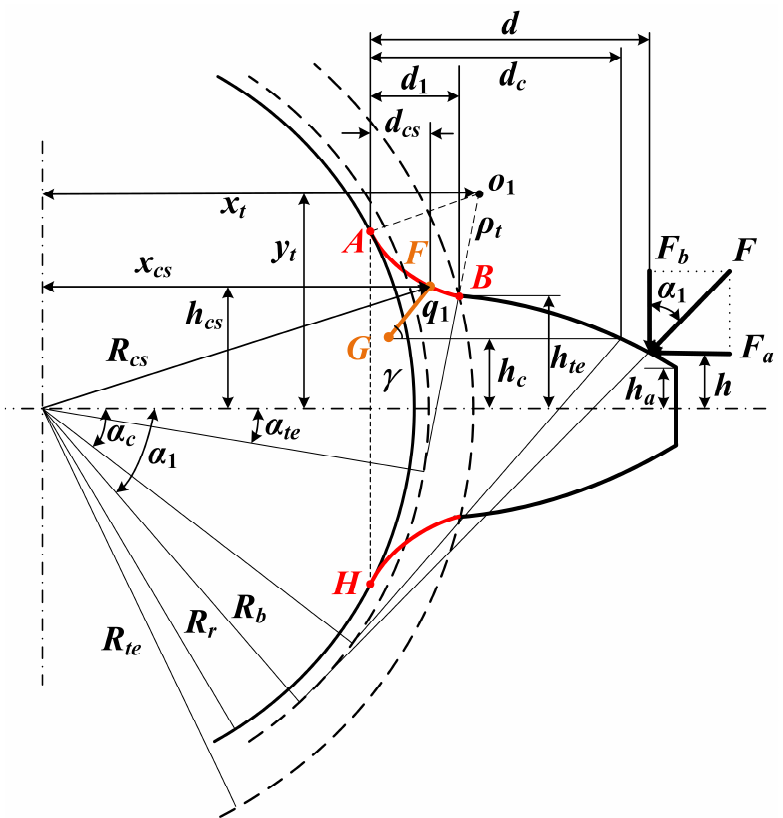
Figure 4. Tooth model with a crack starting on the root fillet ( R cs < R te ).